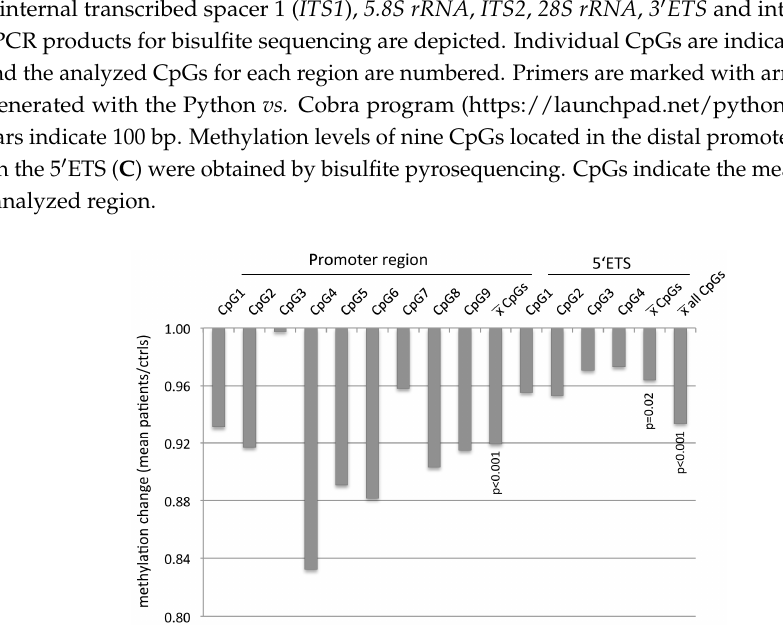
Figure 2. Hypomethylation of rDNA in borderline personality disorder patients. The quotient between mean methylation levels at individual CpG sites and combined sites for the promoter region and 5 ′ ETS in BPD patients and controls (ctrls) were calculated and plotted. Statistical analysis was performed with the two-tailed, paired t -test comparing the mean methylation of matching CpG sites in a specified region.